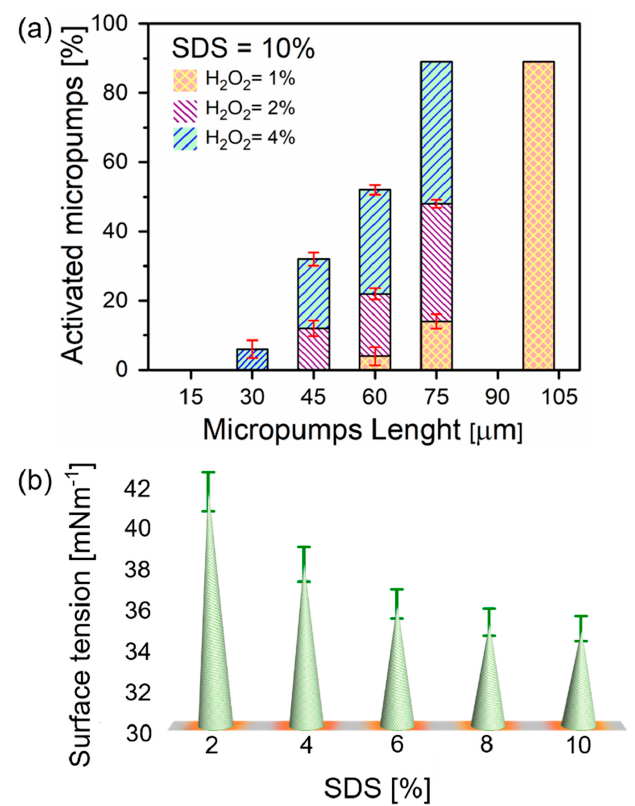
Figure 2. ( a ) Activated microtubes immersed in constant SDS (10% v / v) and in di ff erent concentrations of H 2 O 2 : 1%, 2% and 4% v / v, represented. The crossed right-tilted and left-tilted regions indicate di ff erent concentrations; ( b ) solutions surface tension containing di ff erent SDS concentrations (2–10% v / v).